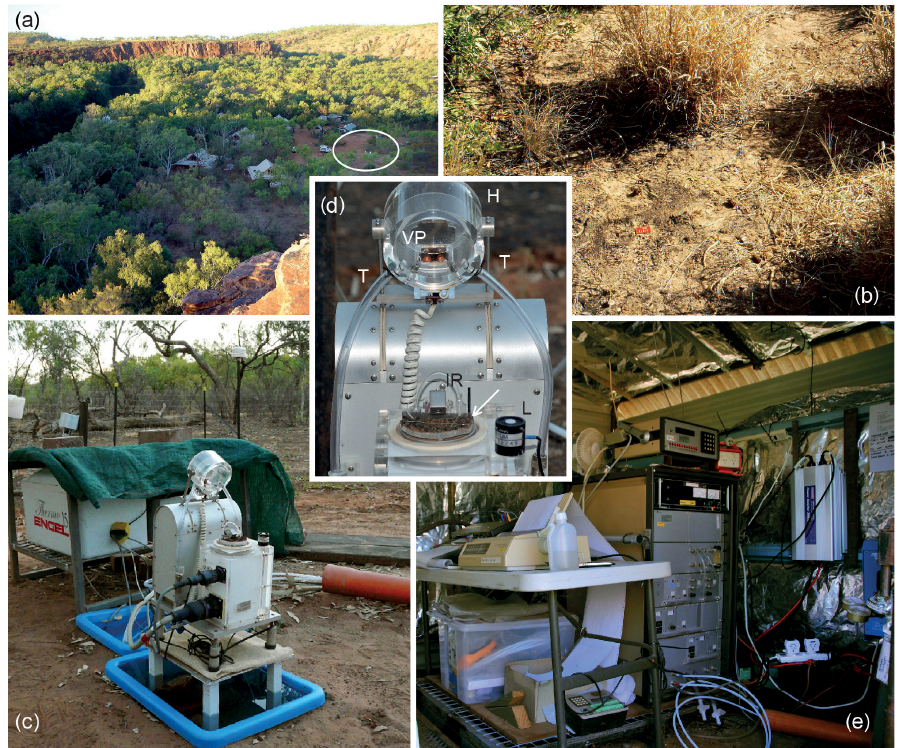
Figure 1. Boodjamulla National Park, measuring site. (a) Housing area for the park rangers and administration with location of biological soil crusts and the measuring site (white circle). (b) Dark patches of a biological soil crust between grass tussocks (red scale 2.5cm). (c) Klapp cuvette system installed in two water-filled basins to prevent small animals from entering the device. (d) Measuring head of the clap cuvette system; the lid is open, exposing the wire mesh basket with the sample (IR means infrared thermocouple, L means light sensor for PAR, T means tubing for gas exchange, VP means vibration plate ensuring regular movement of the air when the cuvette is closed, H means light translucent head closing every 30min for 3min measurement). (e) Room with the data recording devices and control